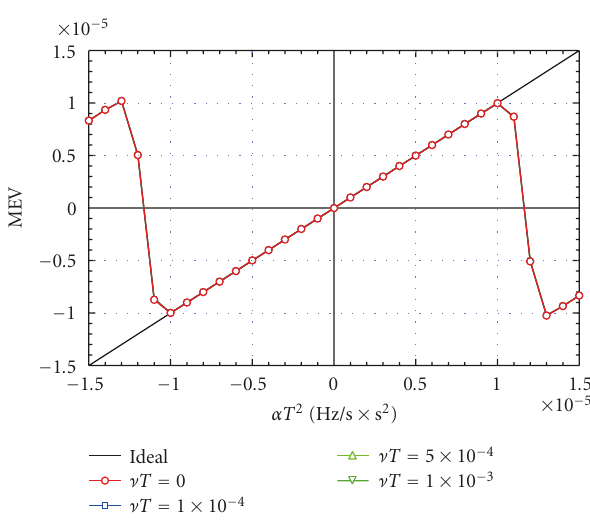
Figure 10: MEV of FRE-3PE estimator for di ff erent values of /N E S 0 —simulation only. 3 blocks of pilots DA ML phase estima- tion, N = 45, M = 384, vT = 1 . 0 × 10 − 3 .